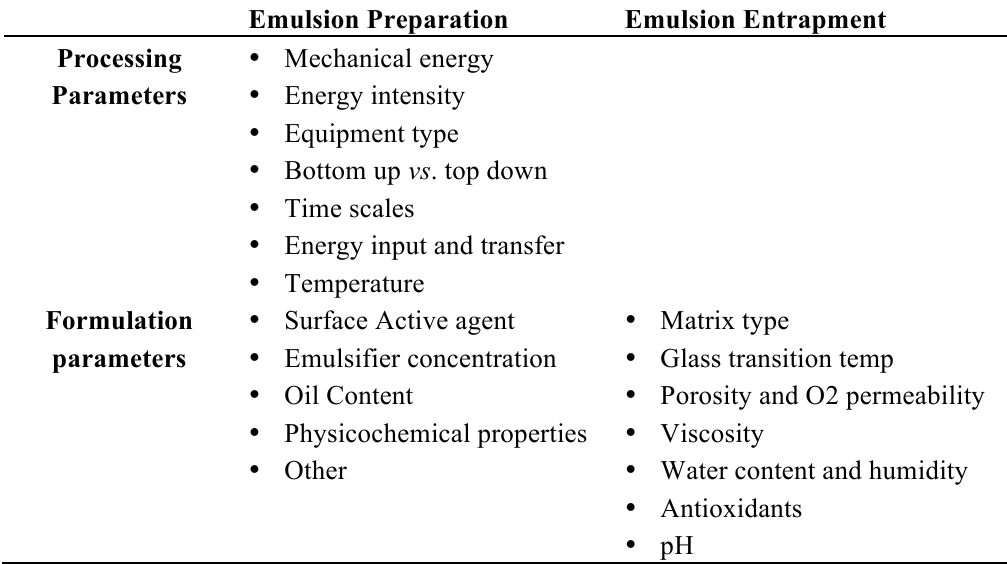
Table 1. Factors influencing emulsion preparation and